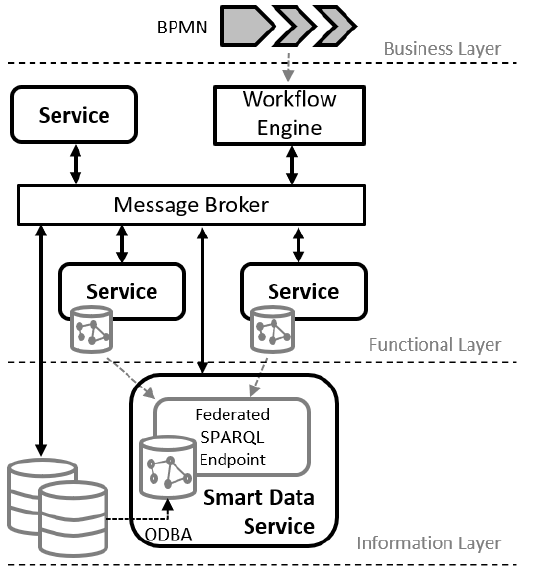
Figure 1. Proposed micorservice framework architecture, in alignment with the RAMI4.0